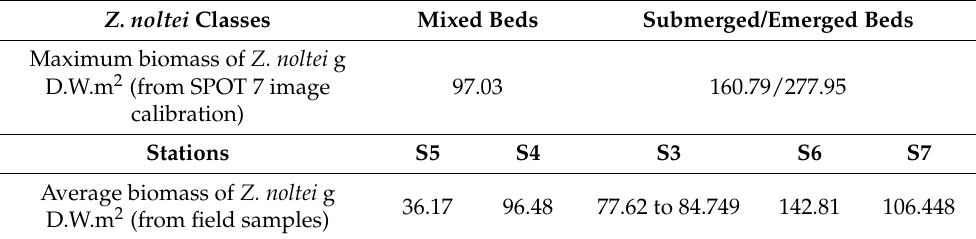
Table 7. The average biomass for Z. noltei in g/m 2 for each station in the Merja Zerga lagoon: S1, S2, S3, S4, S5, S6,